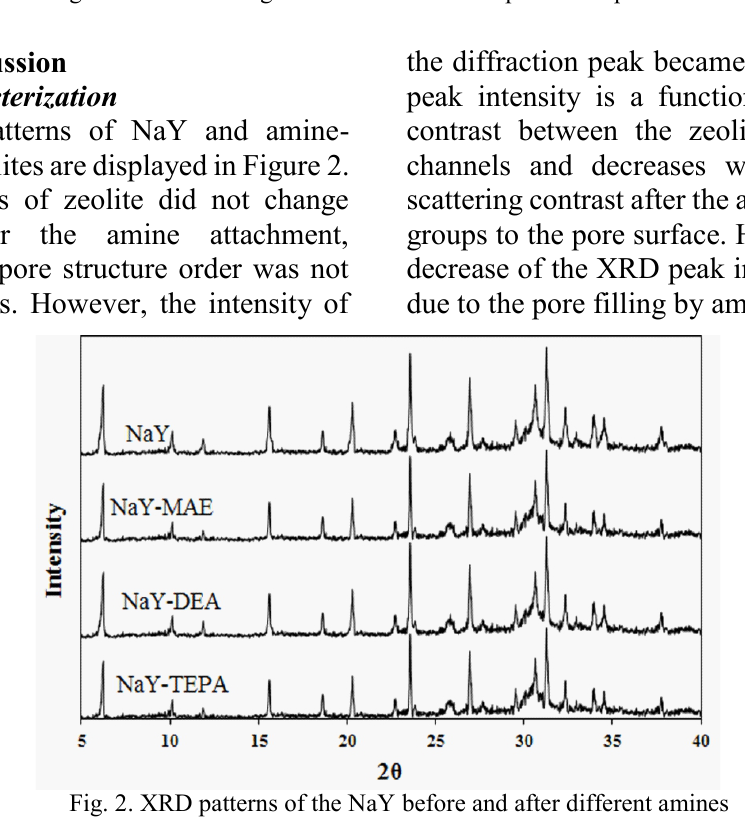
Fig. 1. Schematic diagram of volumetric set up for adsorption test